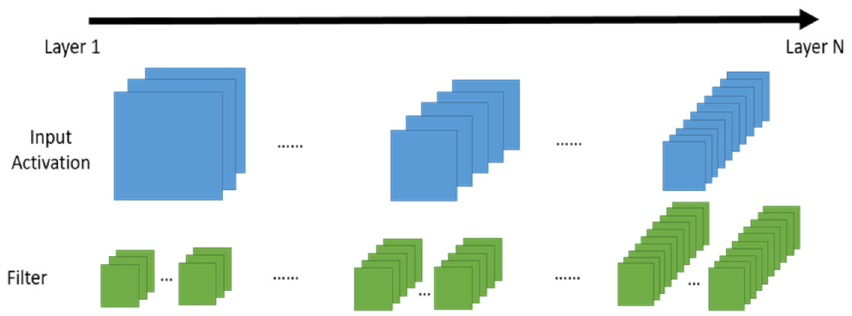
Figure 1. Dimension shape of a CNN.